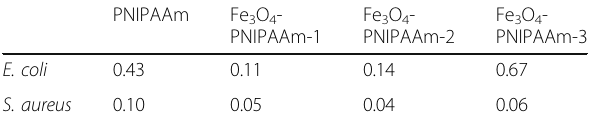
Table 1 The effective concentration of PNIPAAm, Fe 3 O 4 -PNIPAAm-1, Fe 3 O 4 -PNIPAAm-2 and Fe 3 O 4 -PNIPAAm-3 nanoparticles (g/l) at 10% growth inhibition (EC10) determined for Gram-negative Escherichia coli and Gram-positive Staphylococcus aureus